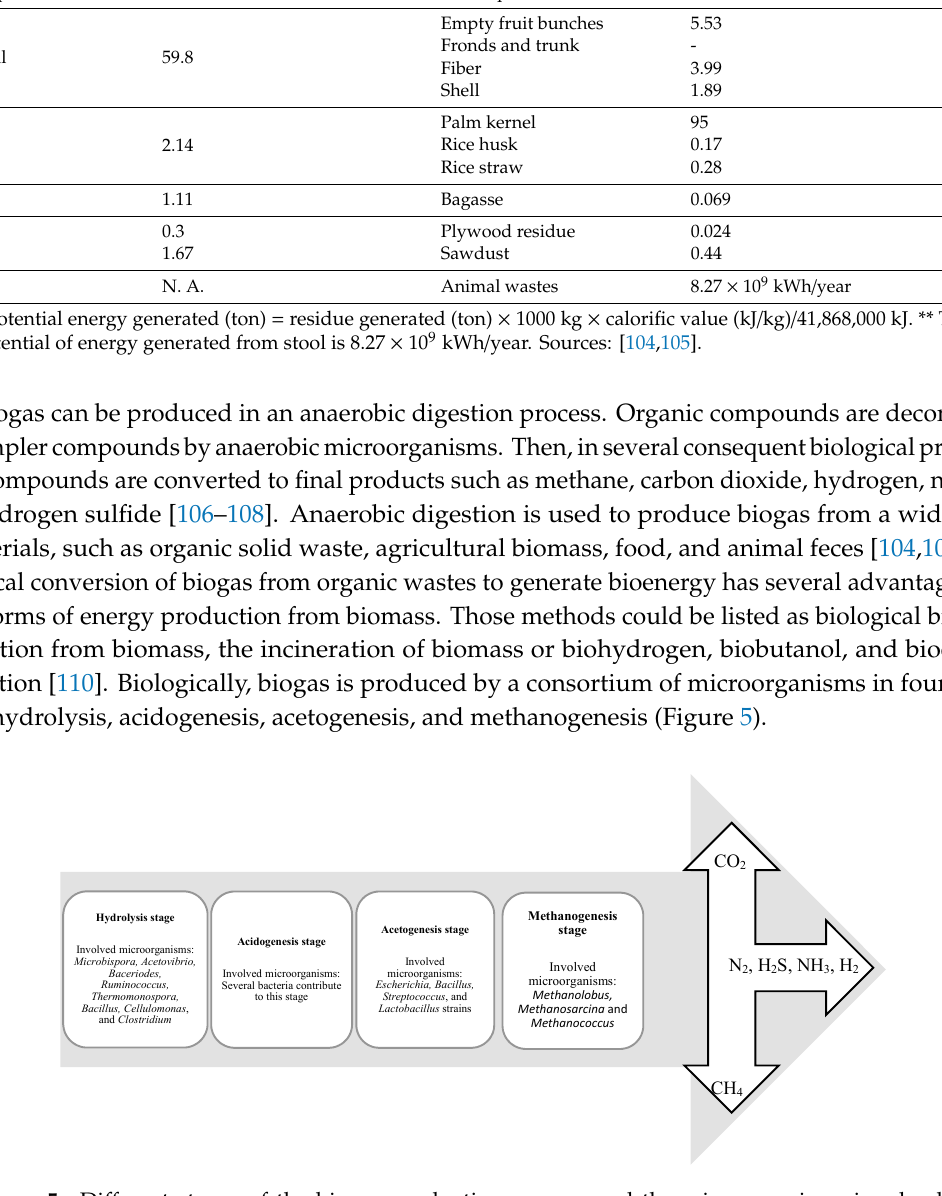
Figure 5. Different stages of the biogas production process and the microorganisms involved in each stage.